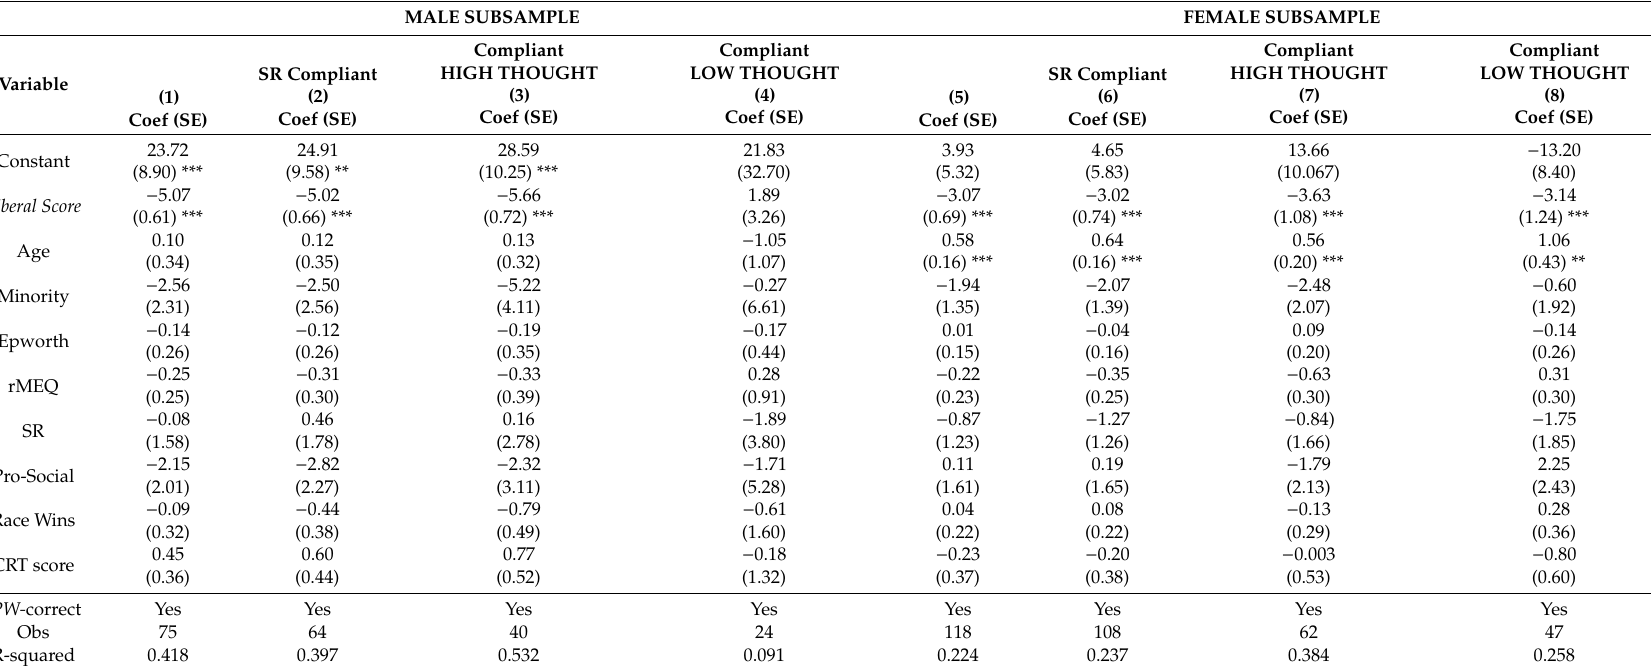
Table 5. Impact of Liberal Score on PRO-GUN-RIGHTS ARGUMENT STRENGTH—males vs